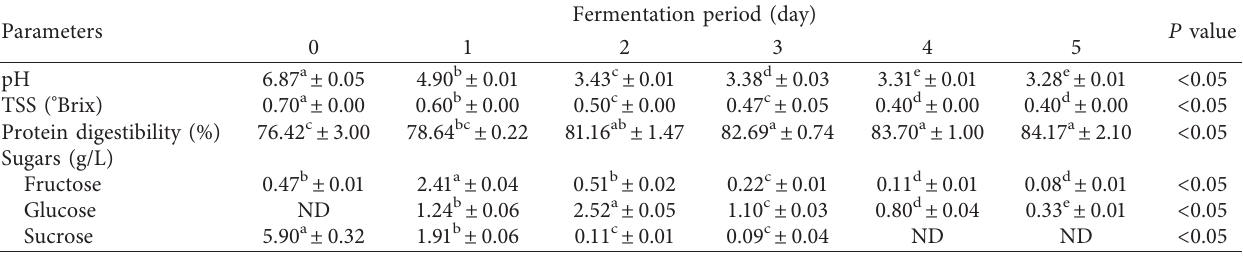
Table 1: Changes in the pH, total soluble solids (TSS), protein digestibility, and sugars profile of unfermented lentil proteins (day 0) and water kefir seed fermented lentil proteins (days